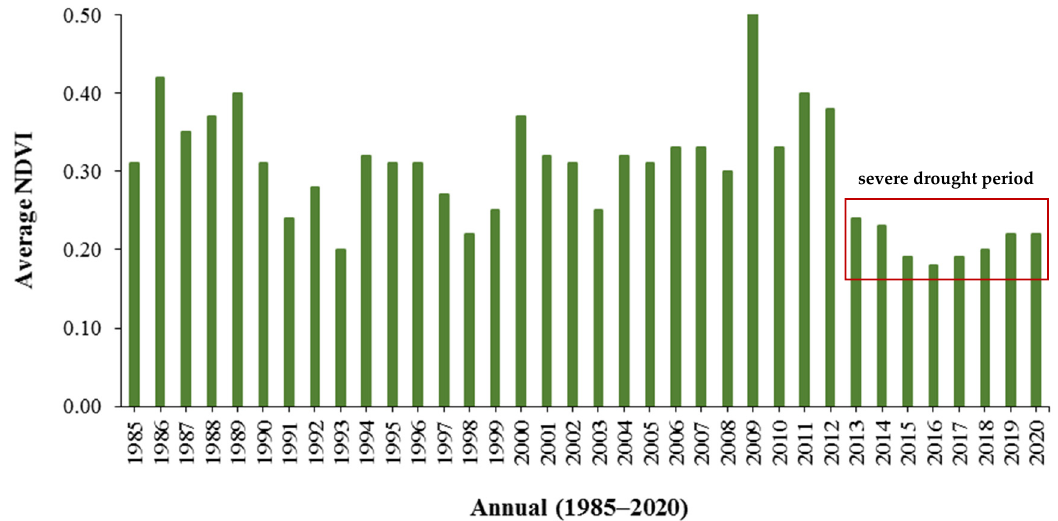
Figure 5. Figure 5. Annual mean time series of the NDVI index, for the semiarid region of Campina Grande– PE, Brazil.